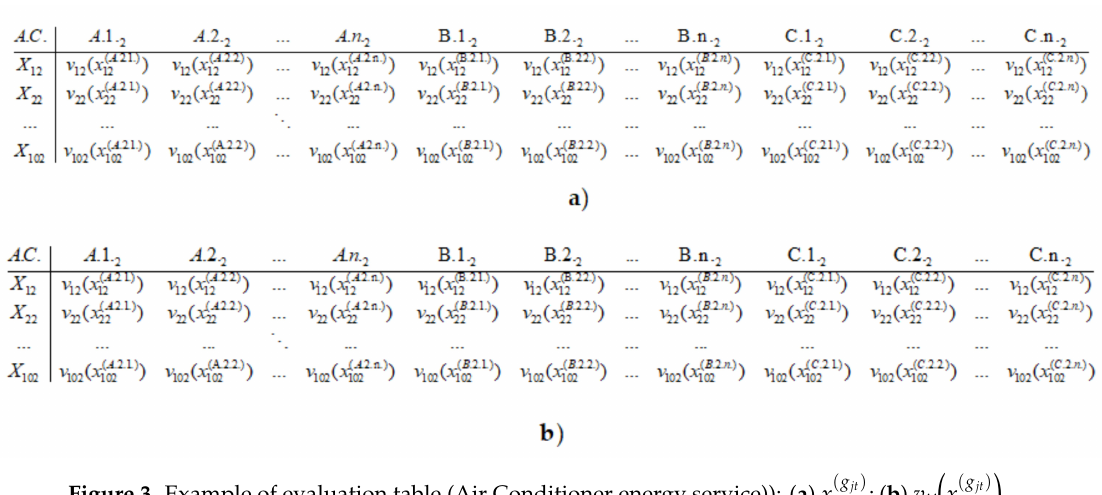
Figure 3. Example of evaluation table (Air Conditioner energy service)): ( a ) x